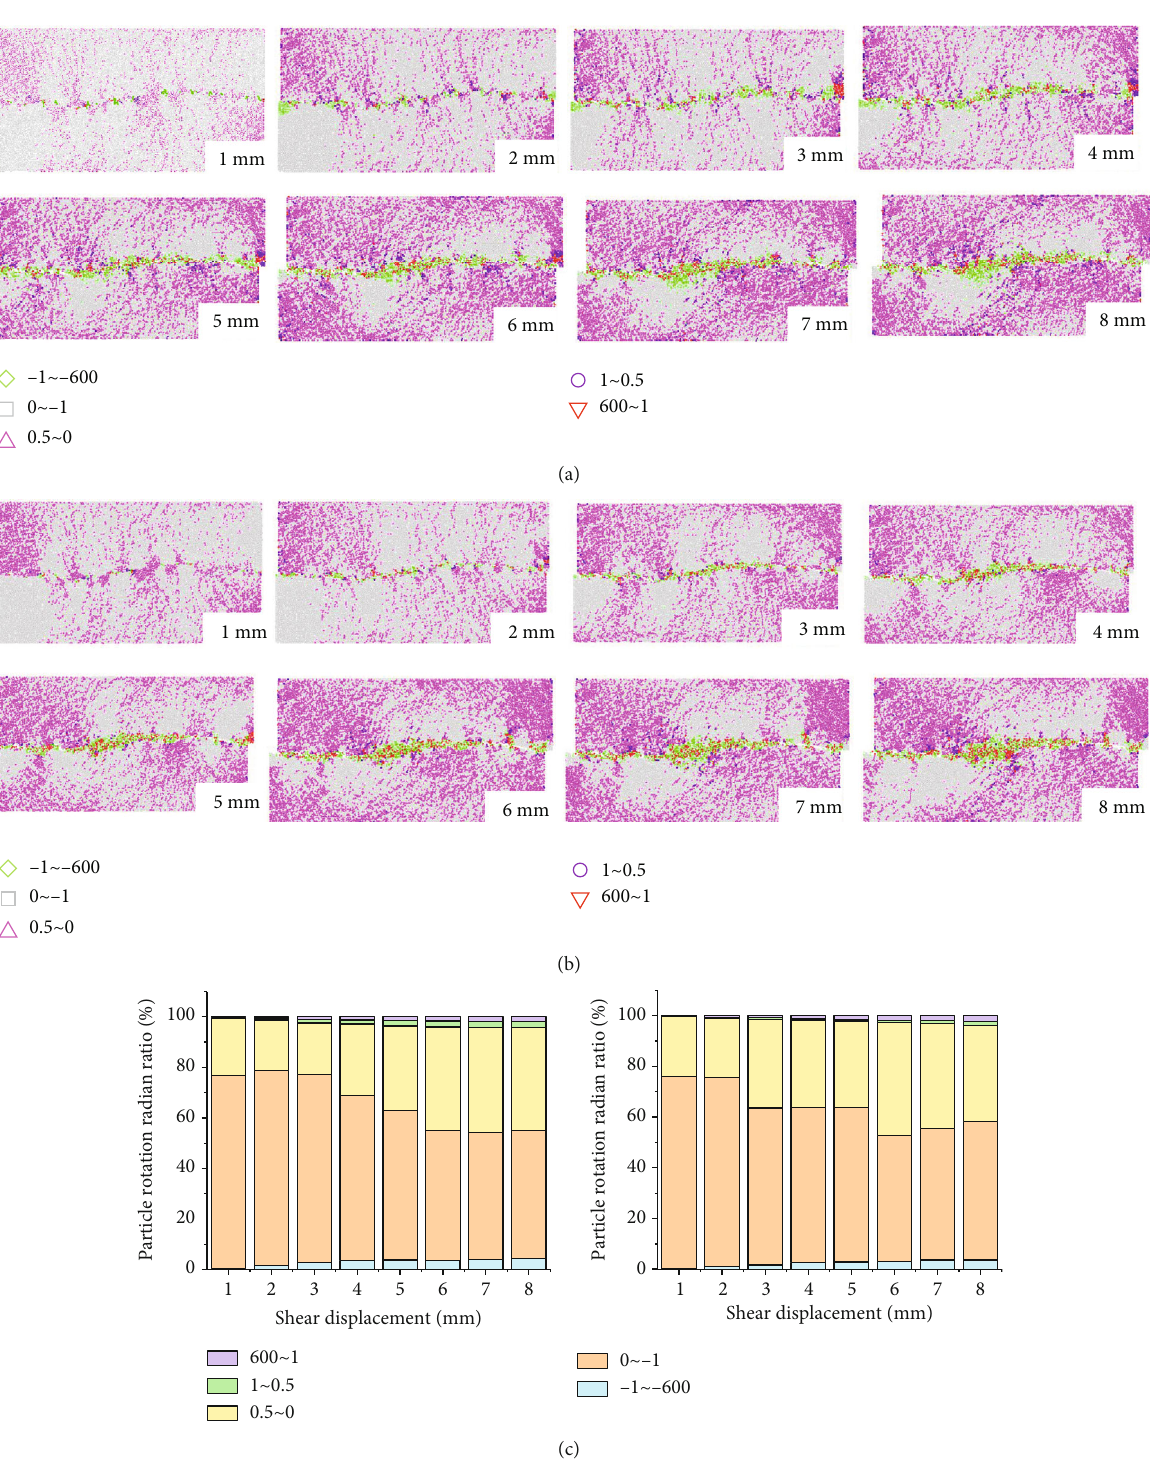
Figure 11: Evolution of particle rotation radian during shearing: (a) low-strength rock joints; (b) high-strength rock joints; (c) the percentage of particle rotation